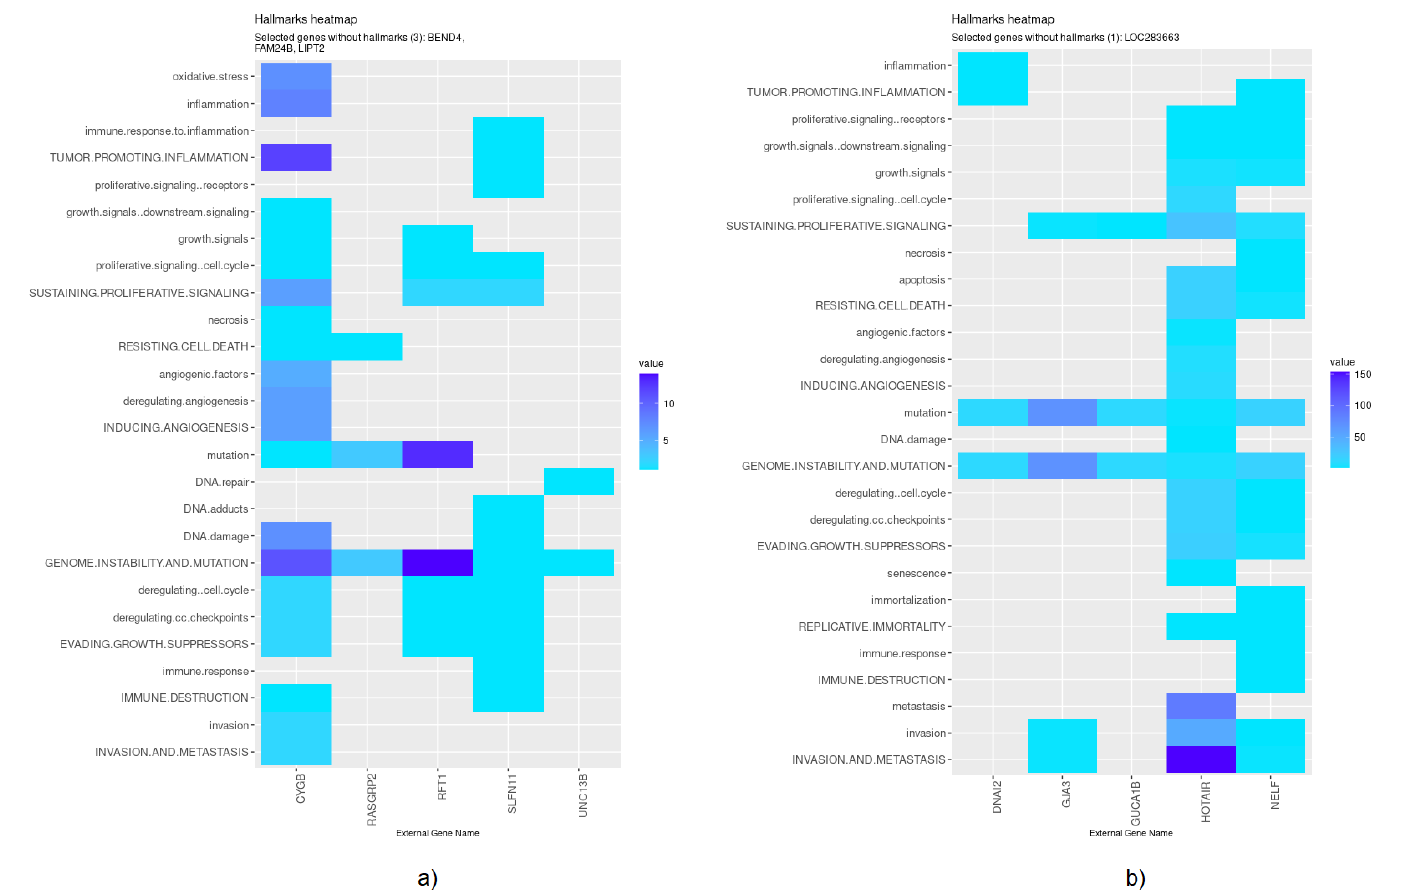
Figure 7. Genes selected by the HubCox and EN models associated with the hallmarks of cancer, given by the CHAT. ( a ) HubCox; ( b ) EN. The value corresponds to the number of hits found in the literature, where light and dark blue correspond to a low and high number of hits,